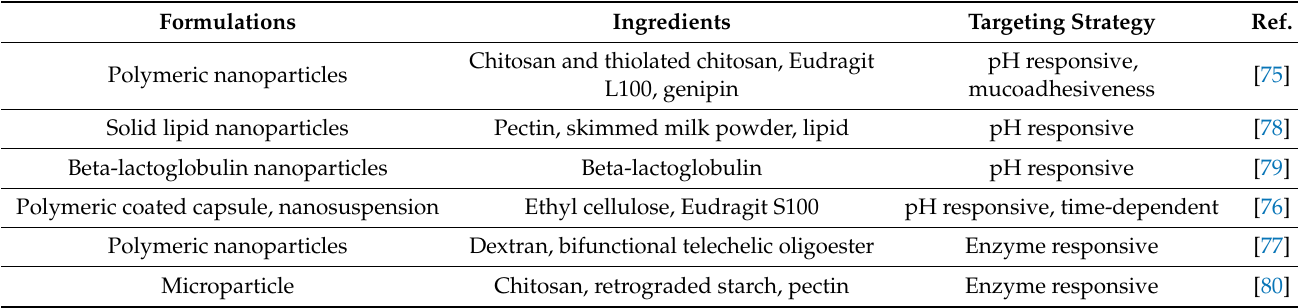
Table 2. Selected examples of oral colon-targeted